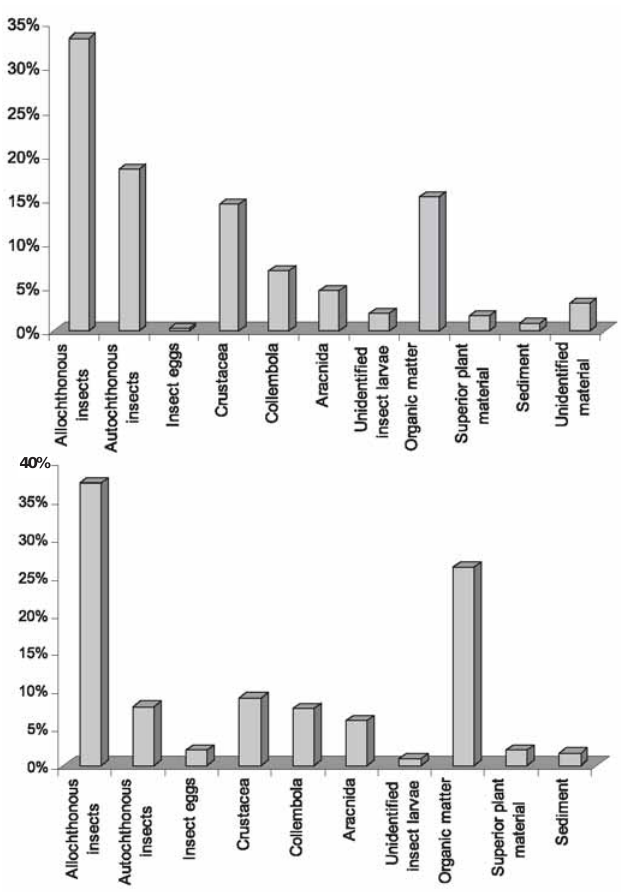
Fig. 1 . Percent composition of dietary items found in the stomachs of Mimagoniates rheocharis. (a) Station 1, March 1998 to March 1999 and (b) Station 2, January 1998 to February 1999.